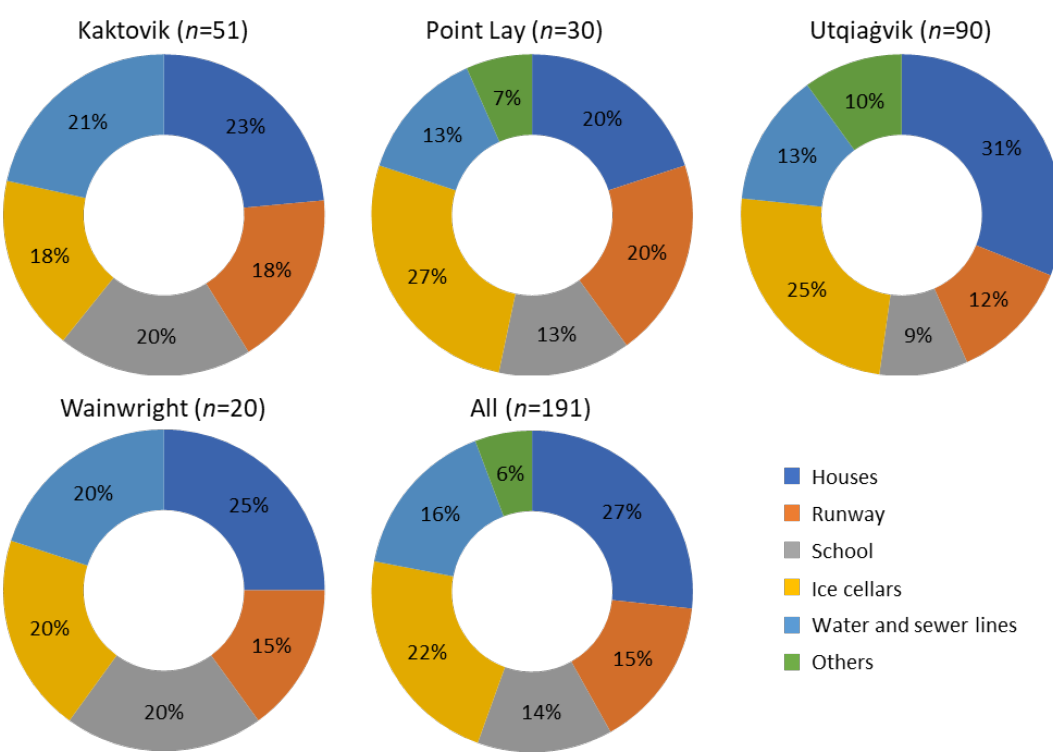
Figure 7. Types of civil infrastructure that are affected by coastal erosion. n is the sample size. Overall, 66% of the respondents reported that they have seen damages to houses caused by permafrost thawing as shown in Figure 8a. More specifically, the percentages of those who reported damage are 72% in Kaktovik, 56% in Point Lay, 65% in Utqiaġvik, and 64% in Wainwright. Among the participants who reported that they have seen damages to residential houses caused by permafrost thaw, the majority reported that there is no repair to such damages, except for those in Wainwright. As shown in Figure 8b, overall, 69% of participants reported no repair to residential house damage in the four communities. Look- ing at results by community, 55% of those who have seen damages in Kaktovik reported no repair, 79% in Point lay, 83% in Utqiaġvik, and 43% in Wainwright. Figure 8. Observations of ( a ) damages and ( b ) repairs to residential houses caused by permafrost thawing.